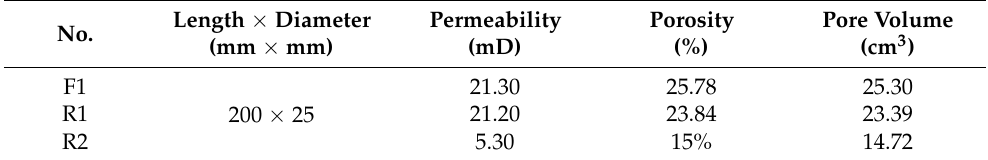
Table 1. Parameters of cores used in the